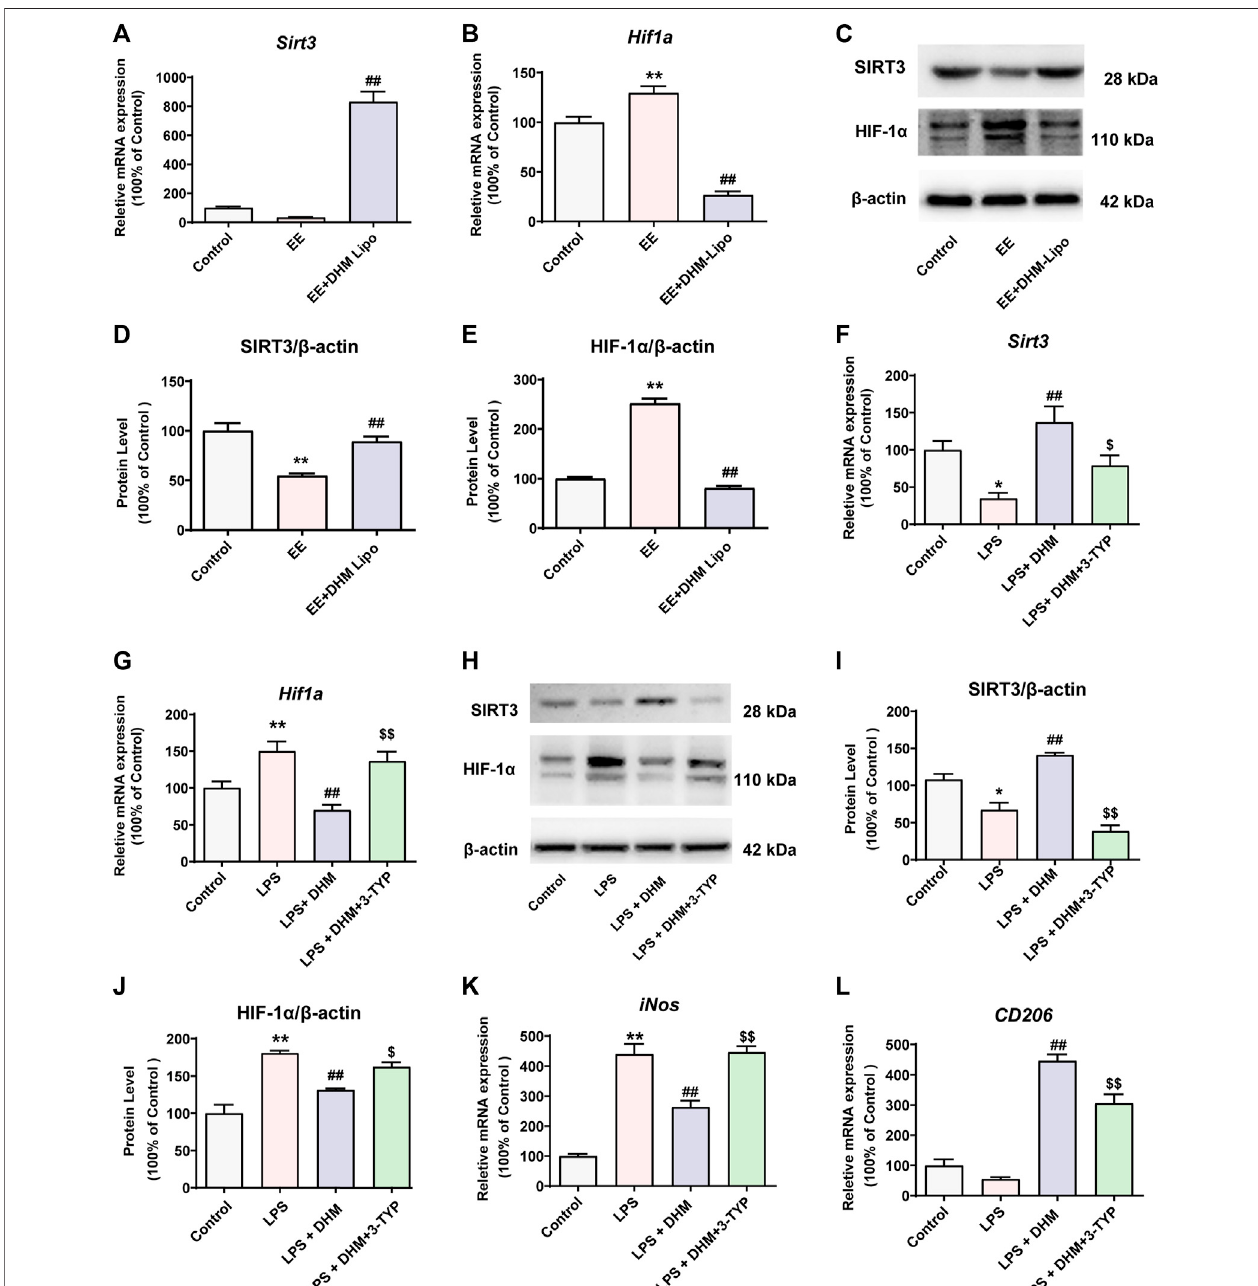
FIGURE6| DHMregulatedmacrophagepolaritythroughtheSIRT3/HIF-1 α signalingpathway (A-E) ThemRNAandproteinexpressionlevelsofSIRT3andHIF-1 α in liver tissue were detected by qRT – PCR(A-B) and western blot(C). Bar charts showing the quanti fi cation of SIRT3/ β -actin (D) and HIF-1 α / β -actin (E) (F-G) RAW264.7 cellsweretreatedwithDHM(10 μ M)for2h,andthenthecellswereexposedtoLPS(100 ng/ml)foranadditional24 h.TheSIRT3inhibitor3-TYP(50 μ M)wasadded1 h before DHM treatment. The mRNA expression levels of Sirt3 (F) and Hif1a (G) were detected by qRT – PCR (H-J) The expression levels of SIRT3 and HIF-1 α were detectedbywesternblot(H).Barchartsshowingthequanti fi cationofSIRT3/ β -actin(I)andHIF-1 α / β -actin(J) (K-L) ThemRNAexpressionlevelsof iNos (K)and CD206 (L) were detected by qRT – PCR. Data are presented as the mean ± SEM ( n = 3). * p < 0.05, ** p < 0.01, compared to the control group; ## p < 0.01, compared to the LPS group; $ p < 0.05, $$ p < 0.01, compared to the LPS + DHM group.